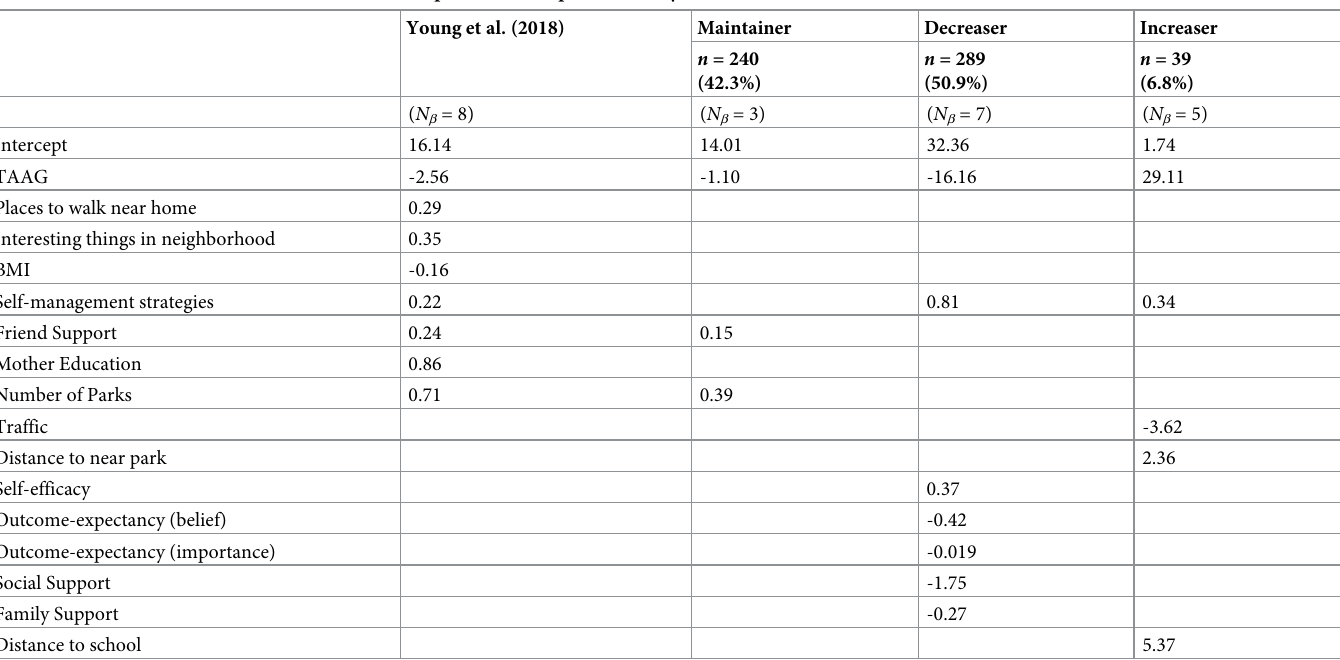
Table 2. Variable selection results in each cluster compared with the previous study.